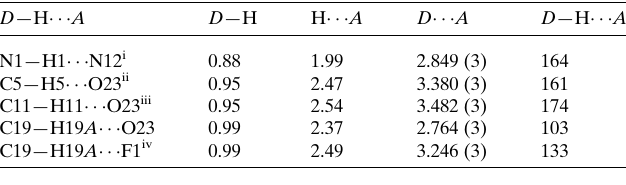
Table 1 Hydrogen-bond geometry (A˚ , (cid:6) ).